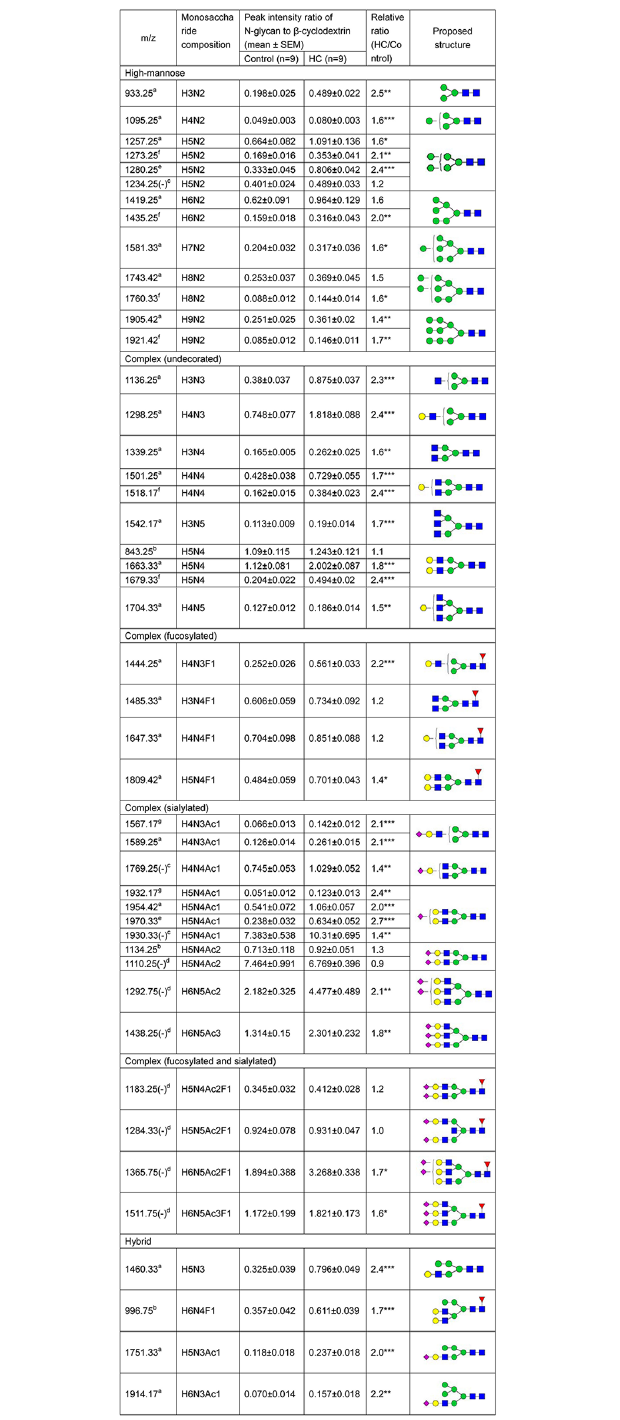
Fig 3. Plasma N-glycans compositions and proposed structures of healthy subjects and hypercholesterolemic patients. Remarks: (-), the N-glycans in negative-ion mode; a-[M+Na] + ; b-[M+2Na] 2+ ; c-[M-H] - ; d-[M-2H] 2- ; e-[M+2Na-H] + ; f-[M+K] + ; g-[M+H]; HC, hypercholesterolemia; H, hexose; N, N- acetylhexosamine; Ac, N-acetylneuraminic acid; F, fucose; Gc, N-glycolylneuraminic acid; * P < 0.05 ** P < 0.01, *** P < 0.001. Structural formulas: blue square, N-acetylglucosamine; green circle, mannose; yellow circle, galactose; red triangle, fucose; purple diamond, N-acetylneuraminic acid.